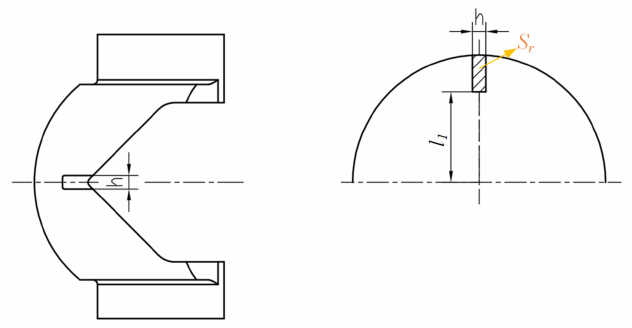
Figure 11. Improvement #2 of the V-ball.